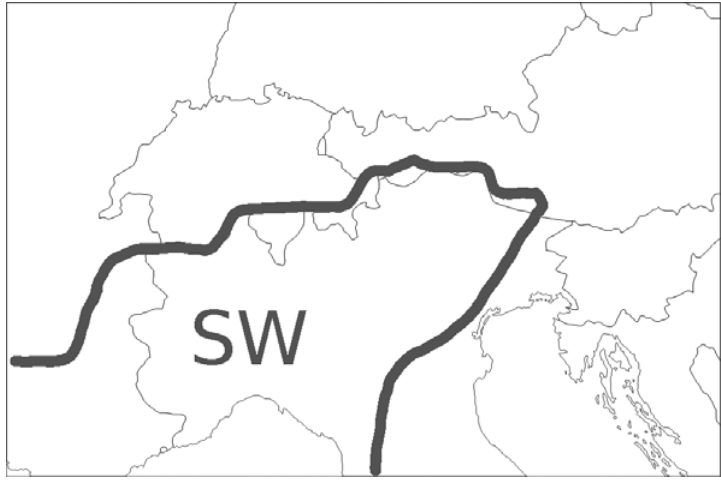
Figure 1. Climatic sector of the Greater Alpine Region considered in the present